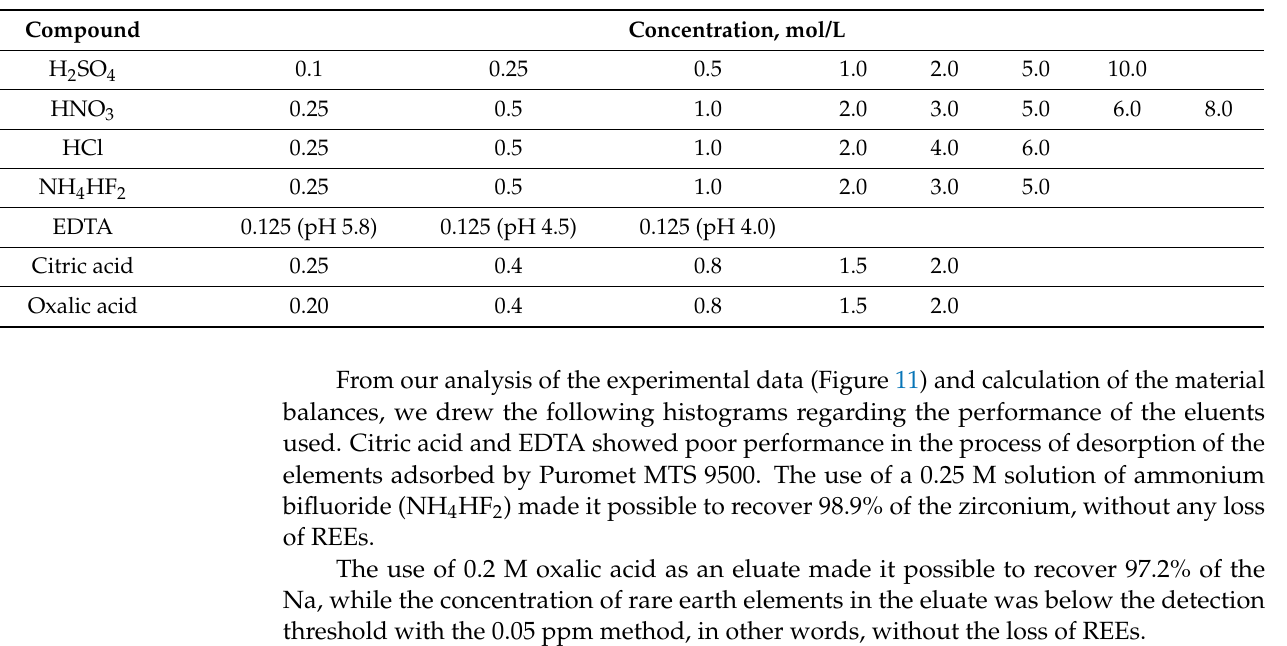
Table 13. Eluents and